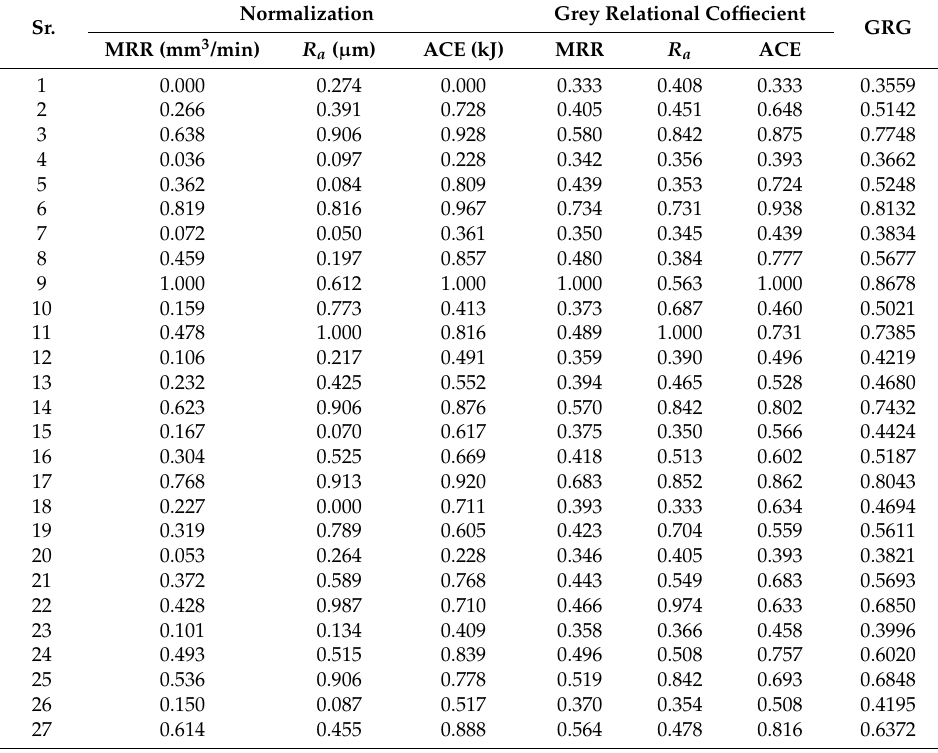
Table A1. The normalization, grey relational coefficient and grey relational grade generation.